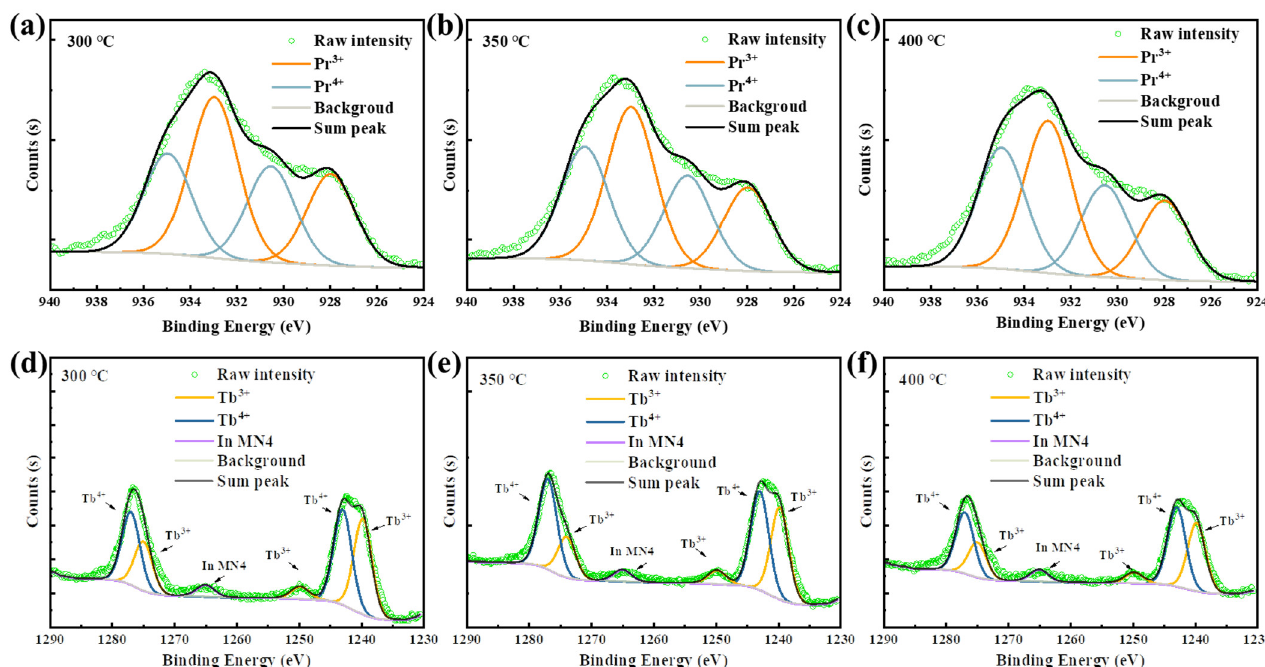
Figure 7. Pr 3 d XPS spectra of the Pr:In 2 O 3 films annealed at ( a ) 300, ( b ) 350, and ( c ) 400 °C; Tb 3 d XPS spectra of the Tb:In 2 O 3 films annealed at ( d ) 300, ( e ) 350, and ( f ) 400 °C.